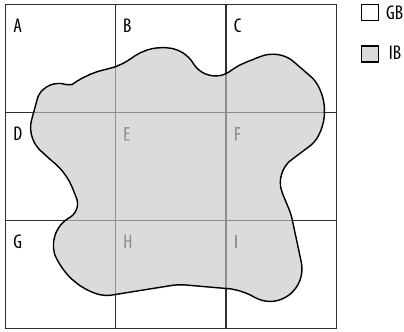
Fig. 1. Design strategies of